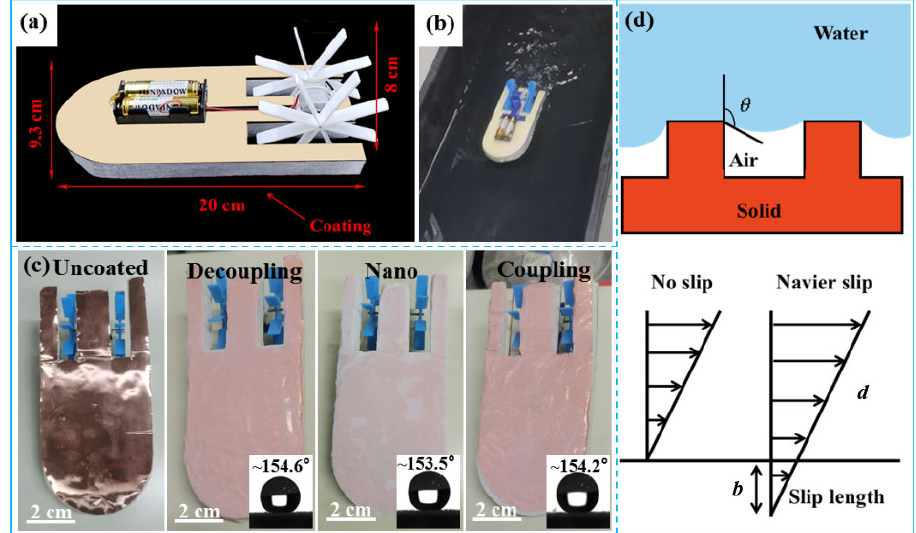
Fig. 10 (a) Boat model and (b) model ship sailing in water, (c) model boats with and without coating, and (d) drag reduction mechanism of coating underwater at air–water interface. θ is the solid–gas contact angle, b is slip length, and d is no slip length.